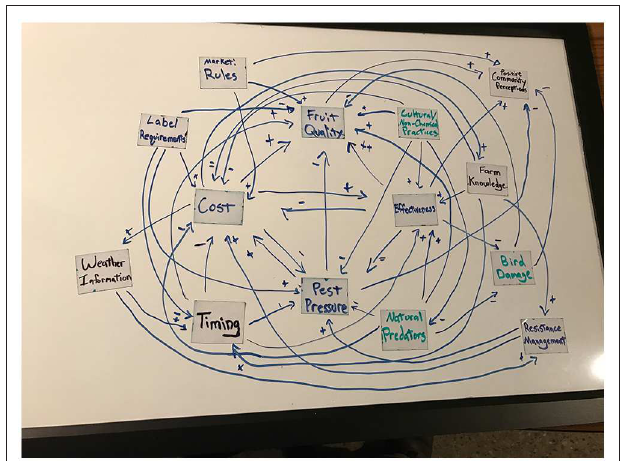
FIGURE 1 | Example of a cherry grower’s mental map on the dry erase board. Arrows represent the causal direction (does A affect B or B affect A). “ + ” indicates a positive relationship (when A increases, so does B) and “–” indicates an inverse relationship (when A increases, B decreases.) A “ ++ ” or “– –” indicates a very strong